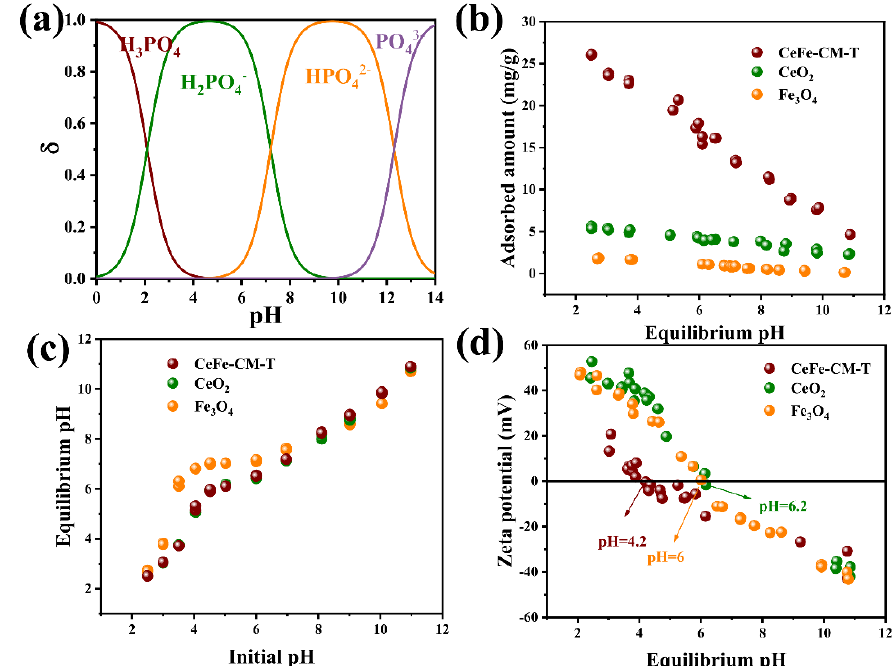
Figure 6. ( a ) Distribution of phosphate species at different solution pH; ( b ) Effect of solution pH on phosphate adsorption onto CeFe-CM-T, CeO 2 , and Fe 3 O 4 ; ( c ) change in solution pH before and after phosphate adsorption; ( d ) zeta potentials of CeFe-CM-T, CeO 2 , and Fe 3 O 4 at different equilibrium pHs.